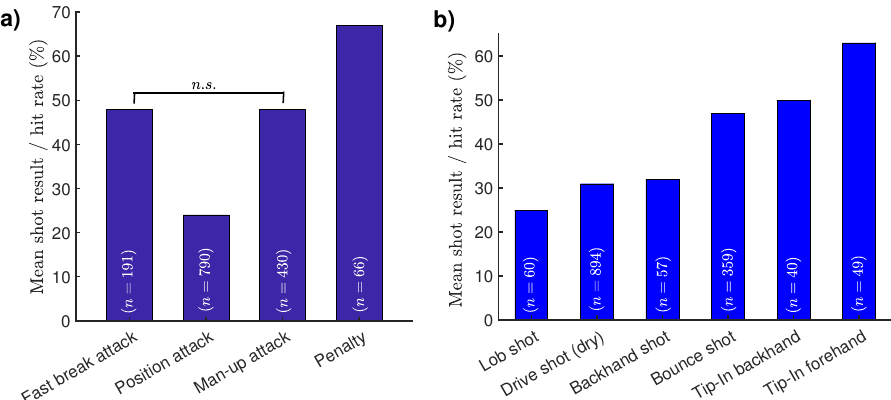
Figure 4. The different hit rates ( a ) for the four typical team attack phases ( F 3;1473 = 38.51; p < 0.001; Bonferroni post-hoc, p < 0.05) and ( b ) for the six different shot techniques.